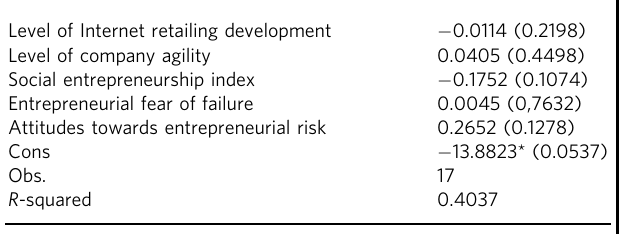
Table 4 The regression analysis results.